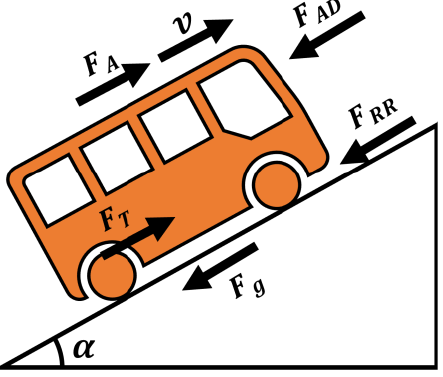
Figure 4. Diagram of forces on the bus.